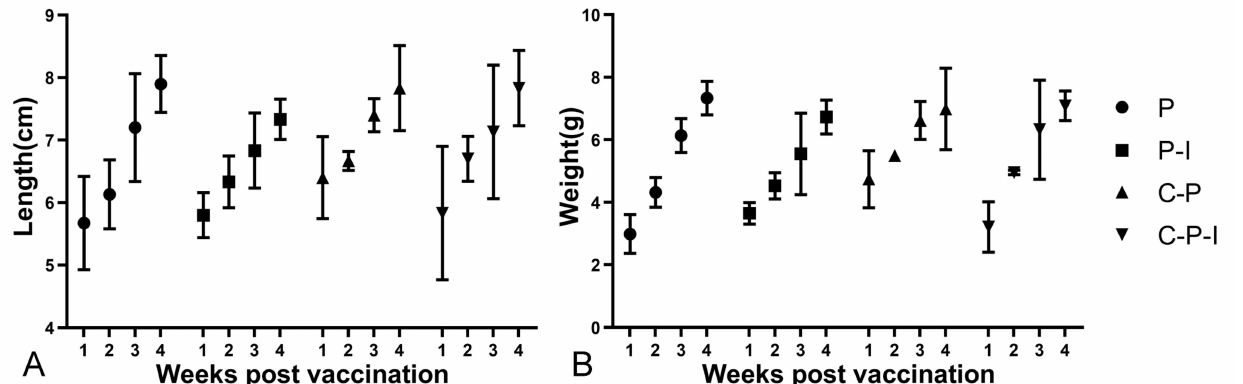
Figure 10. Changes in body length and weight of fish in each group from 1st to 4th weeks after immunization ( A ): Length (cm). ( B ): Weight (g). P: pBudCE4.1 group; P-I: pBudCE4.1-IRF3 group; C-P: CP-pBudCE4.1 group; C-P-I: CP-pBudCE4.1-IRF3 group. Results are shown as mean ± standard deviation of values randomly obtained from three